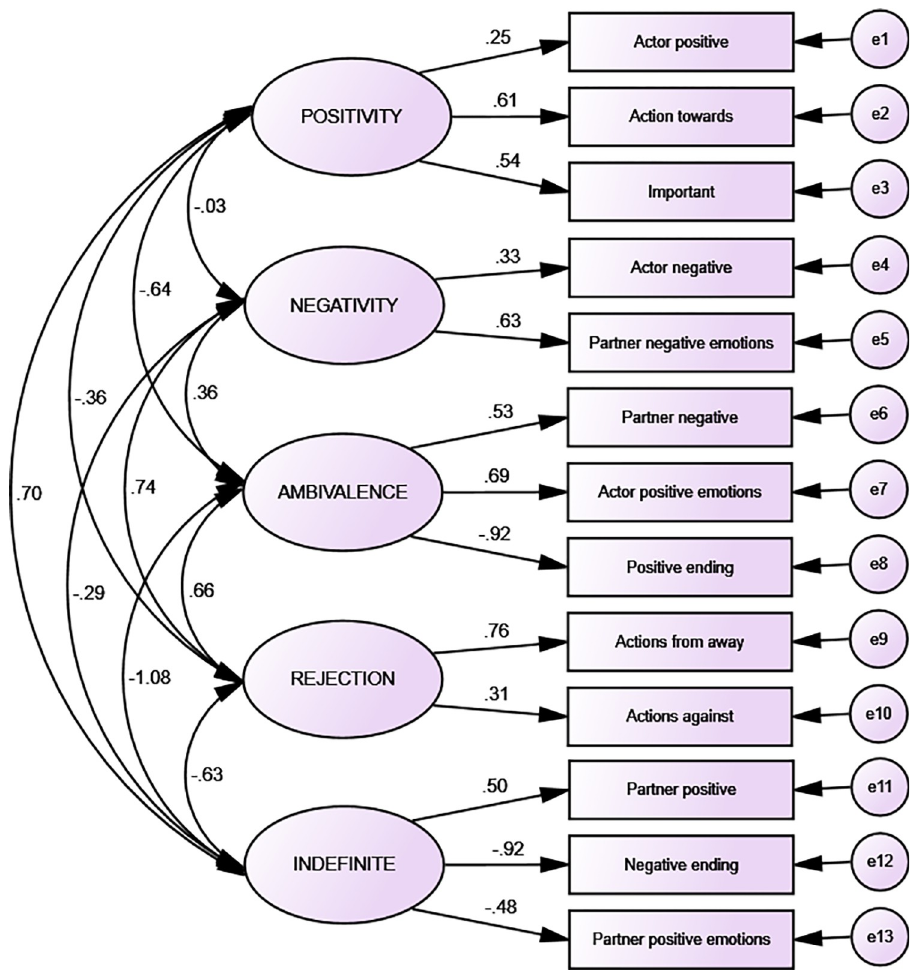
Fig 2. Love: Confirmatory factor analysis ( n =